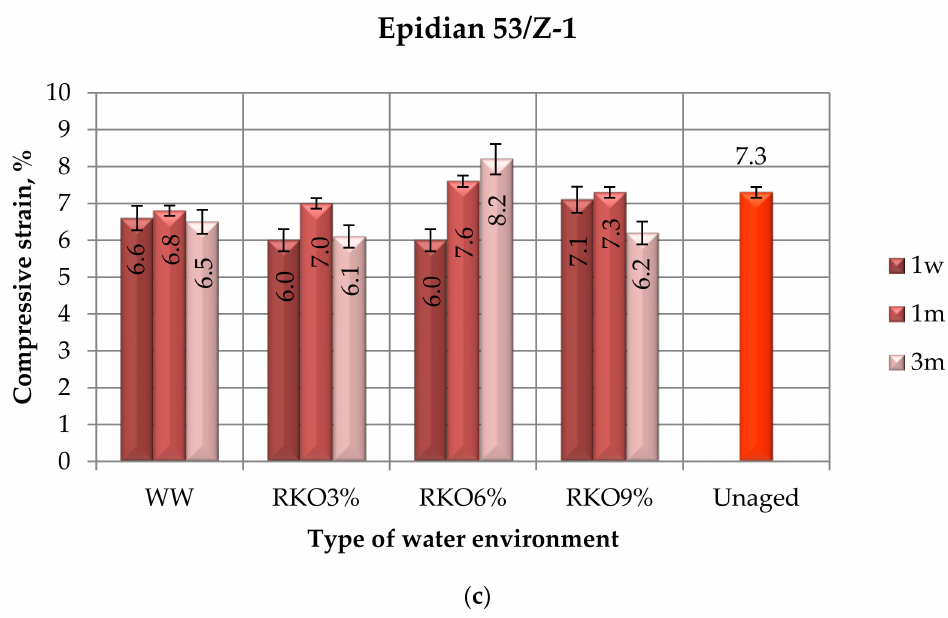
Figure 2. Results of the compression tests of the unmodified epoxy compound (Epidian 53 / Z-1) seasoned in four water environments for the following periods of time: one week, one month, and three months: ( a ) compressive strength, ( b ) compression modulus, ( c ) compressive